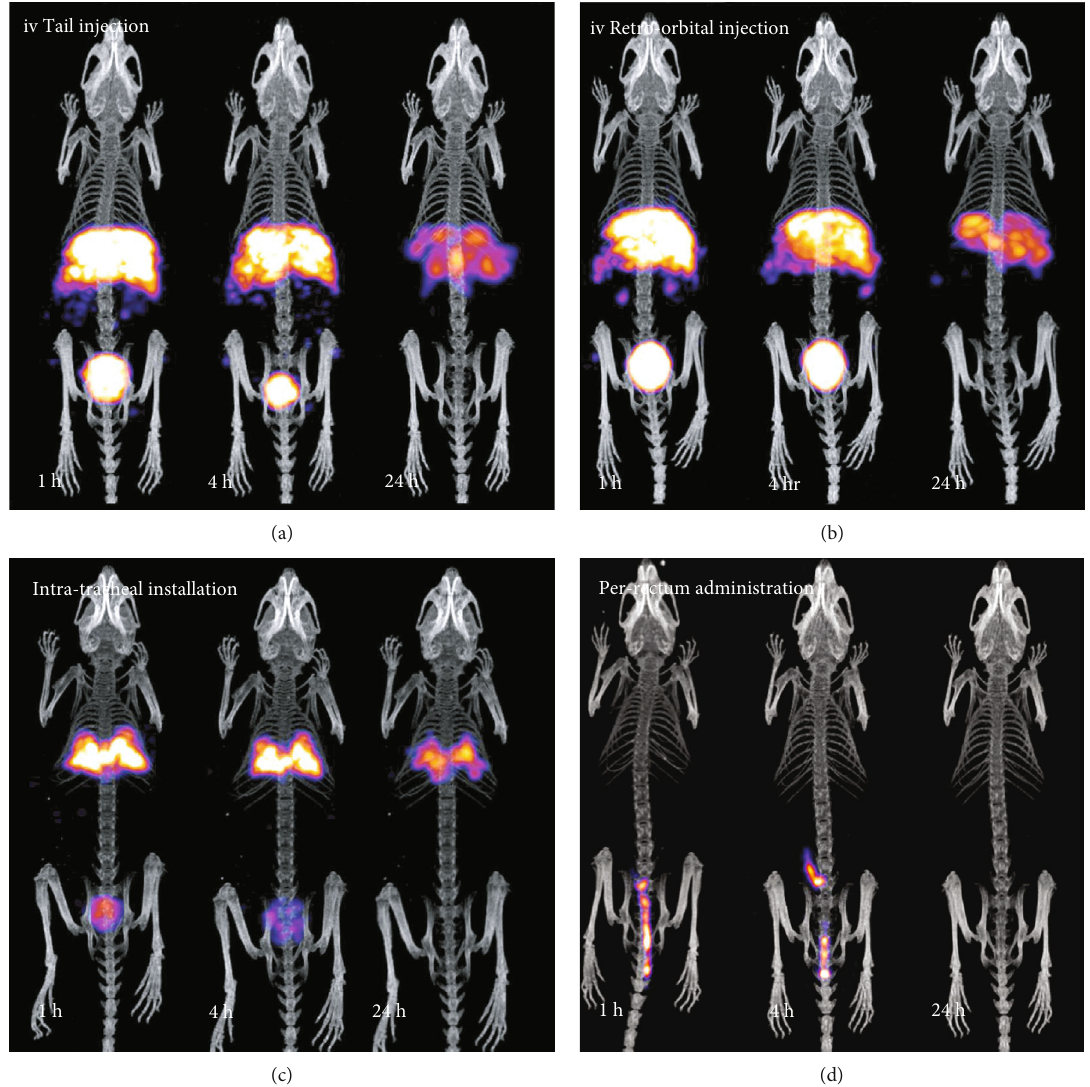
Figure 9: Indicative images of all the administration routes ( n = 5 ), for the selected times postadministration, taken with the Molecubes systems: (a) standard IV tail injection, (b) retro-orbital IV injection, (c) intratracheal installation, and (d) per rectum administration. Time point postinjection is shown on each image. All images are